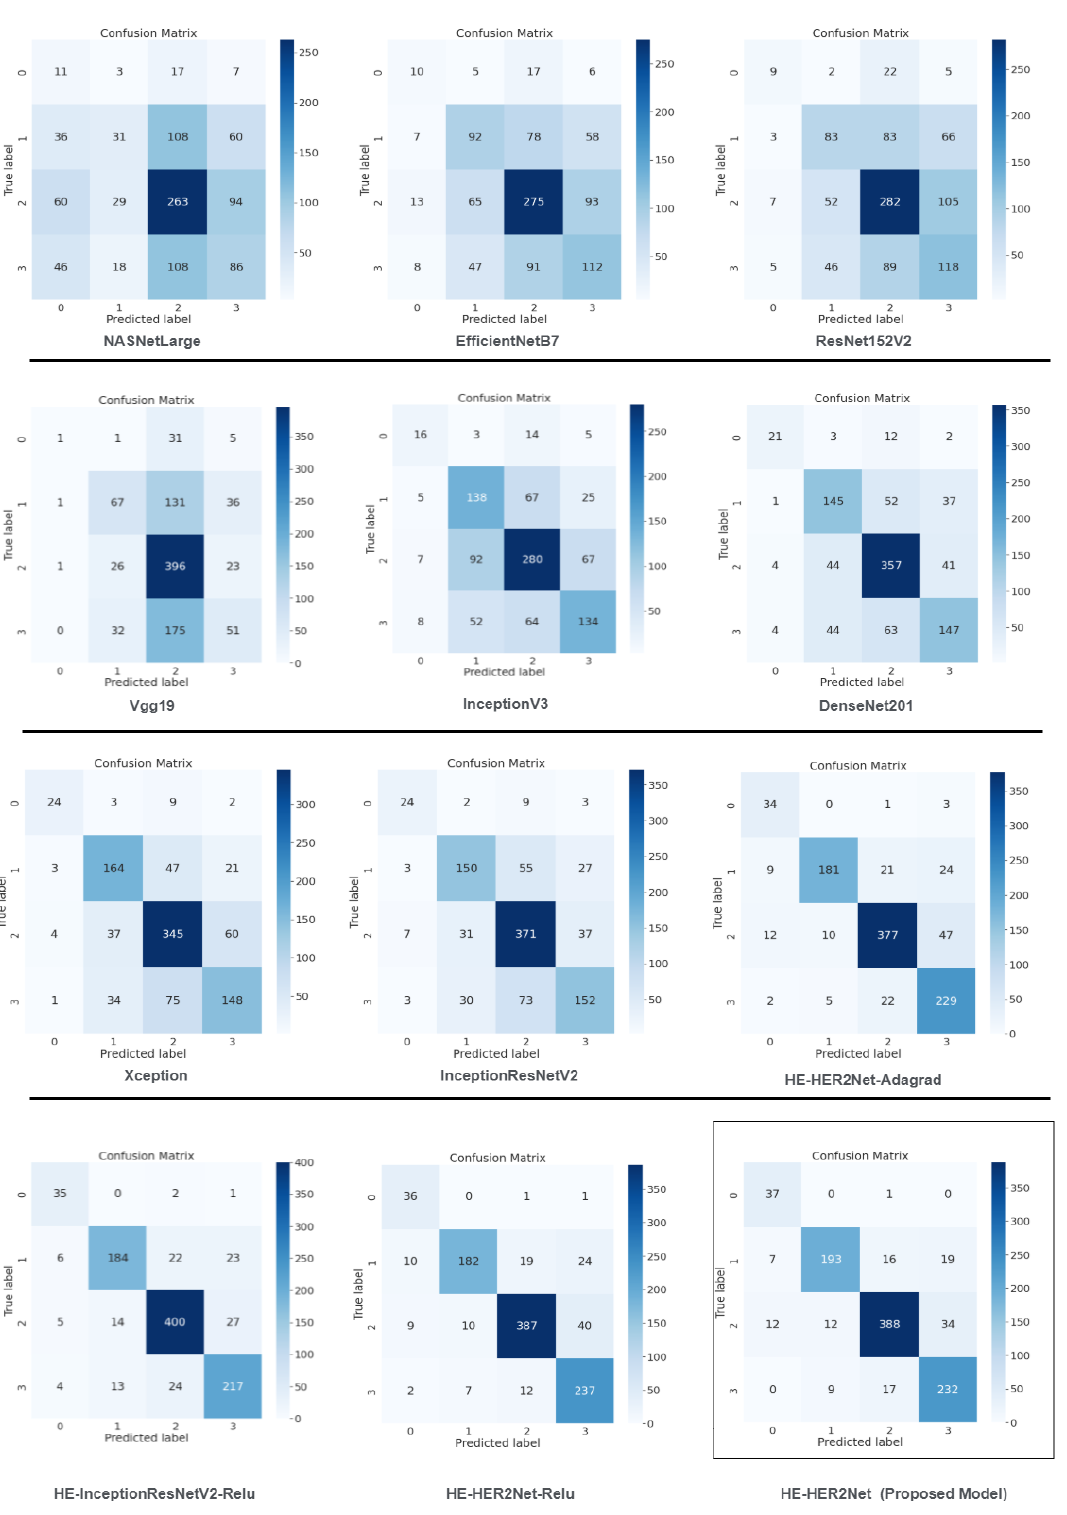
Figure 6. This broad figure shows the performance of the confusion matrix of all the models, including